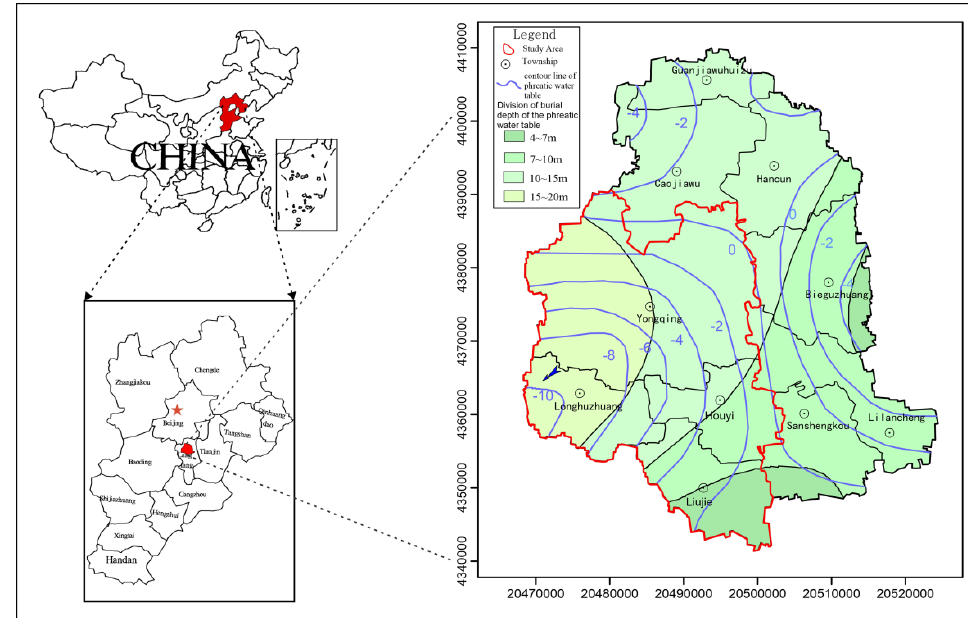
Figure 1. Groundwater burial depth classification and iso-water level map in the study area.